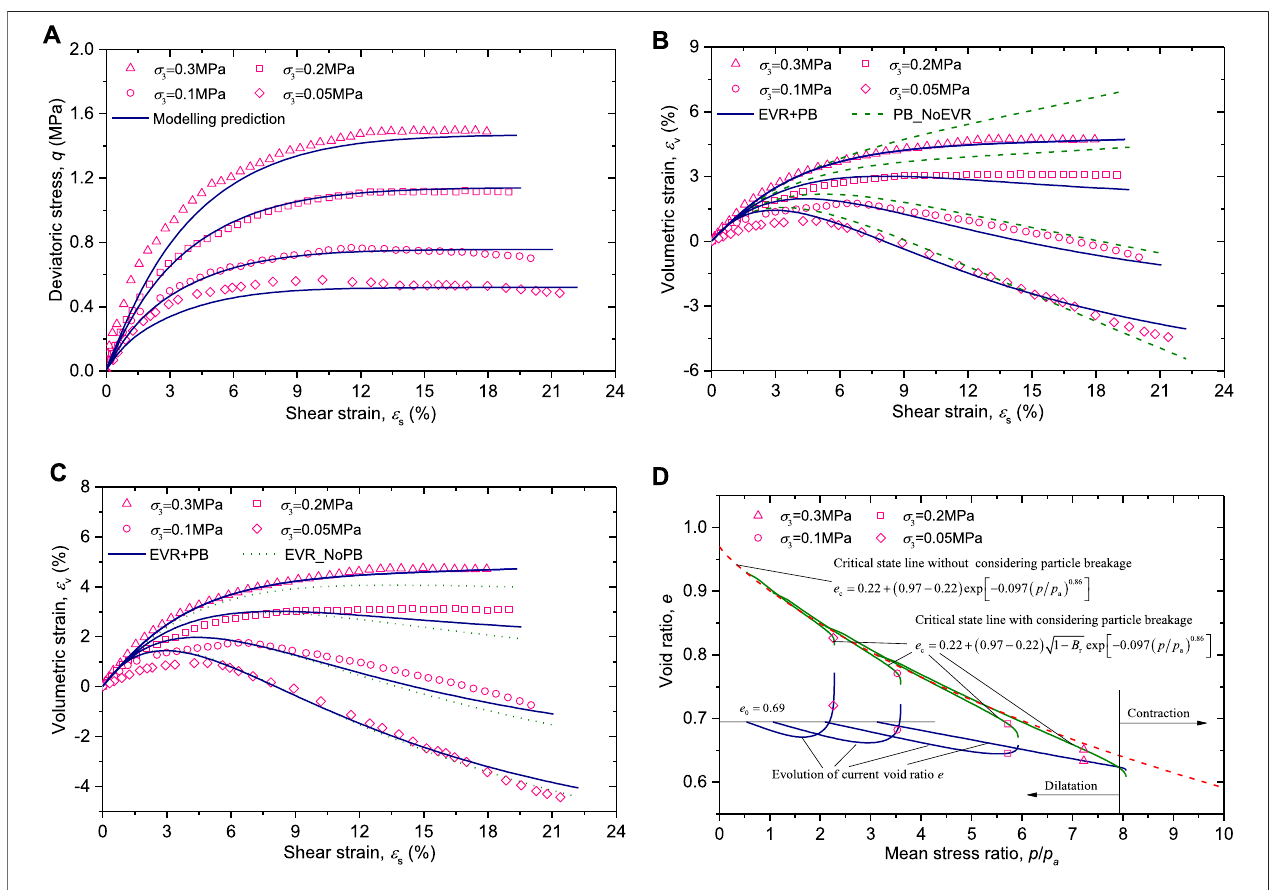
FIGURE 3 | Model predations and experimental results of the crushed basalt (test data were from [23]).